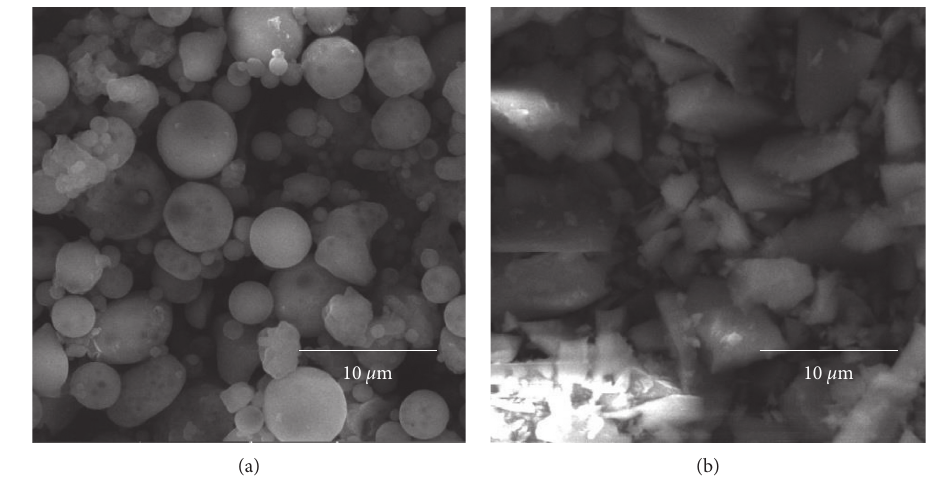
Figure 2: SEM images of (a) FA and (b)